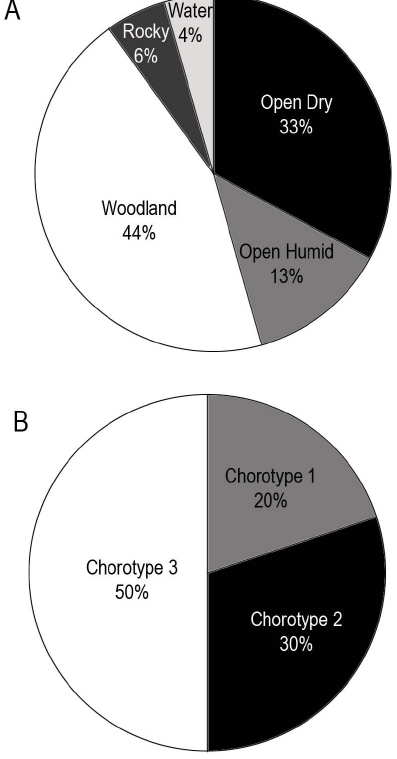
Fig. 6. (A) : small-vertebrate association by habitat. (B) : small- vertebrate association by chorotype. Data have been taken from the percentage of the minimum number of individuals.